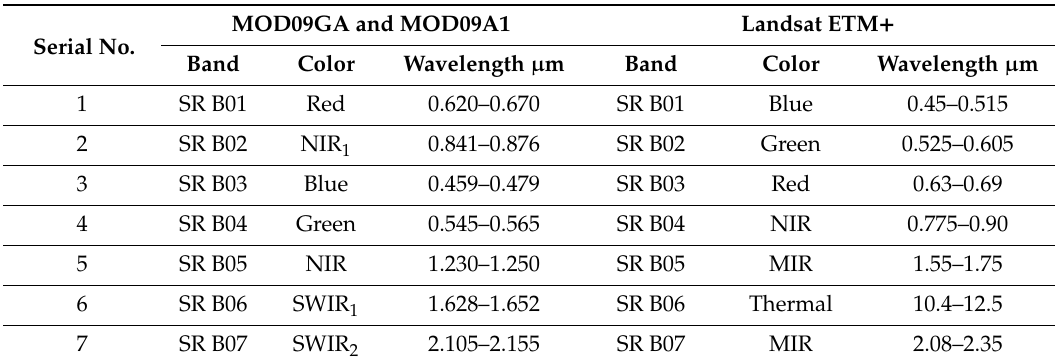
Table 1. Spectral band information of Moderate Resolution Imaging Spectroradiometer (MODIS) and Landsat Enhanced Thematic Mapper Plus (ETM + ) used in this